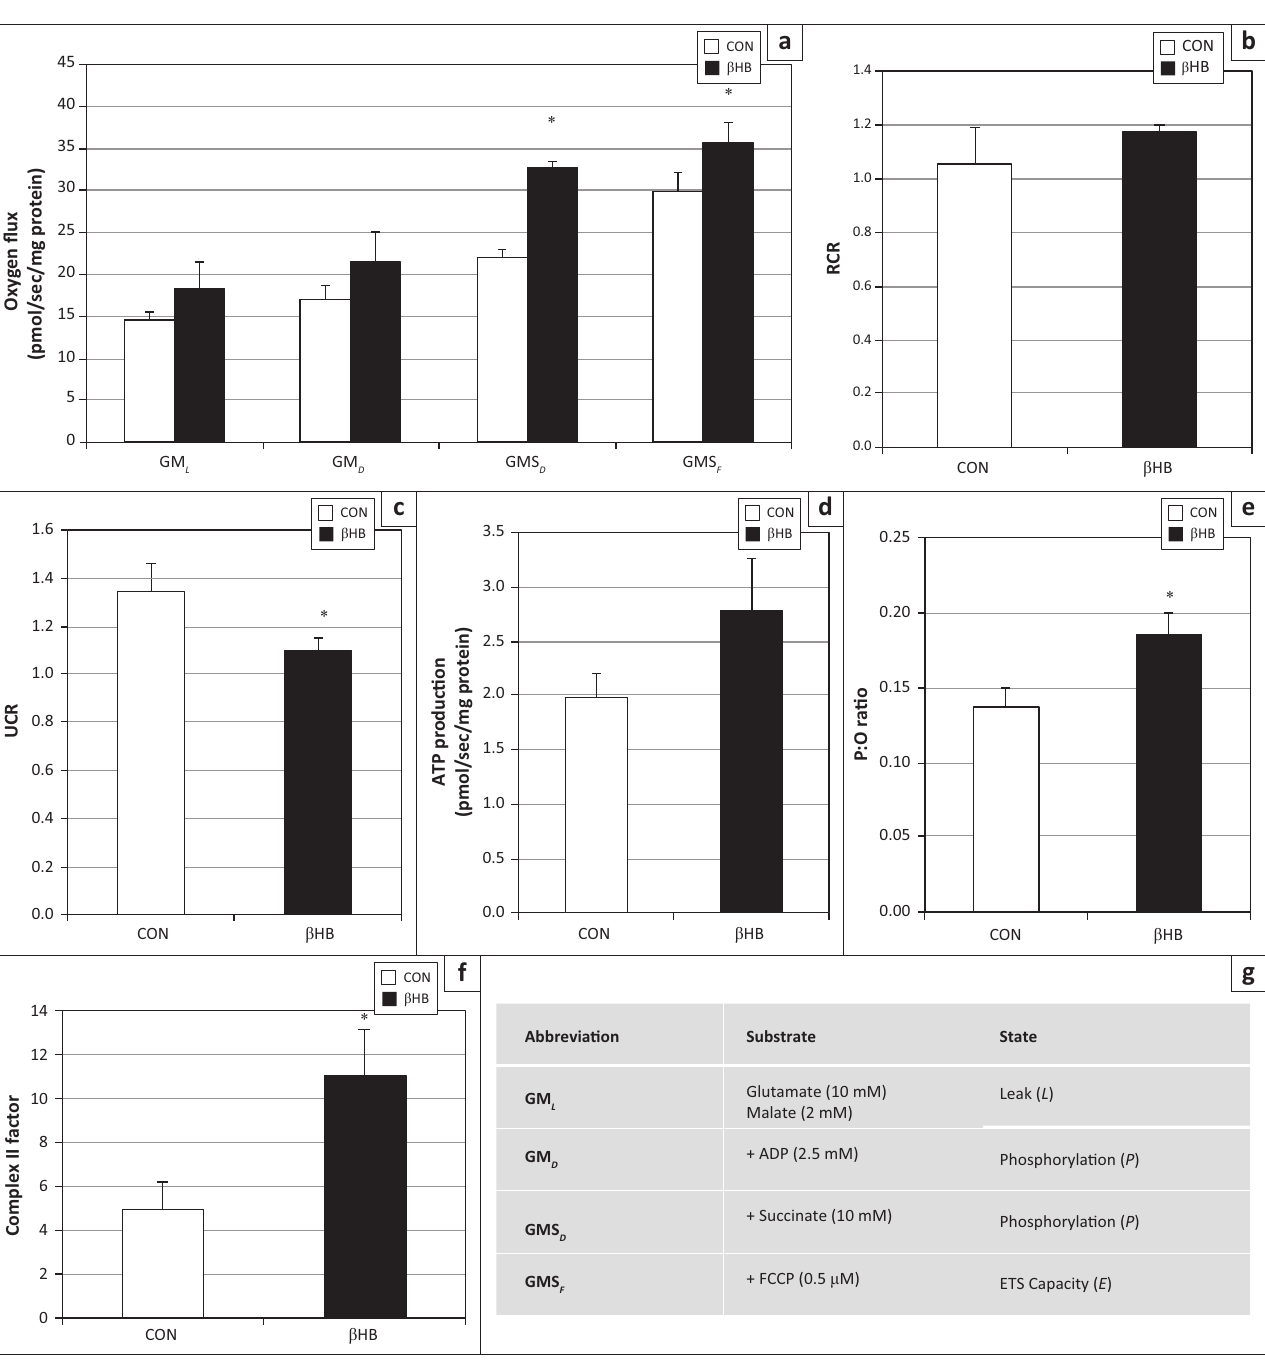
/GM ), uncoupling control ratio (c; UCR; GMS /GMS ) and complex II D L F D use at that same time) were determined 2